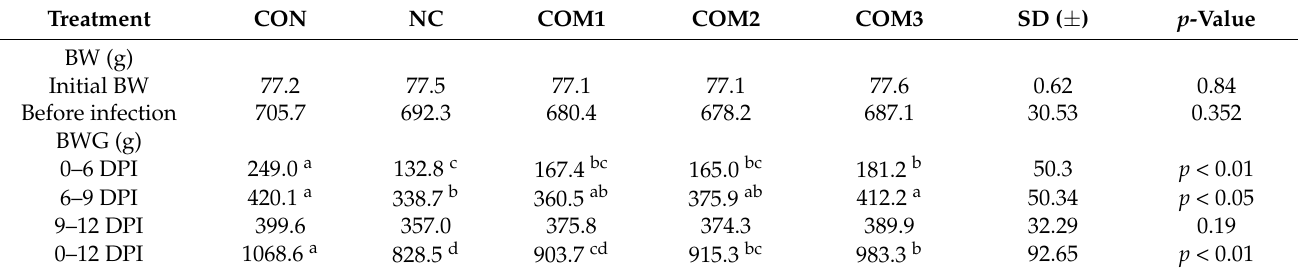
Table 2. Effect of B. subtilis -EV or B. subtilis -cNK-2 on rEF-1 α vaccination based on body weight gain post- E. maxima -challenge infection.